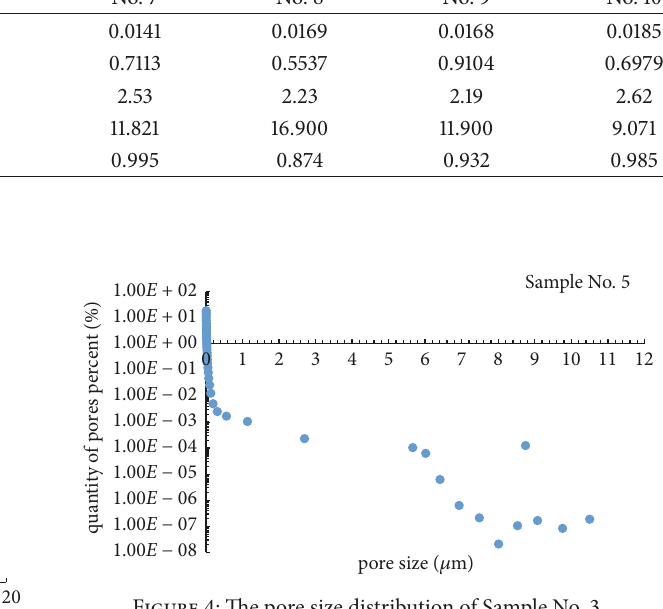
Figure 4: The pore size distribution of Sample No.